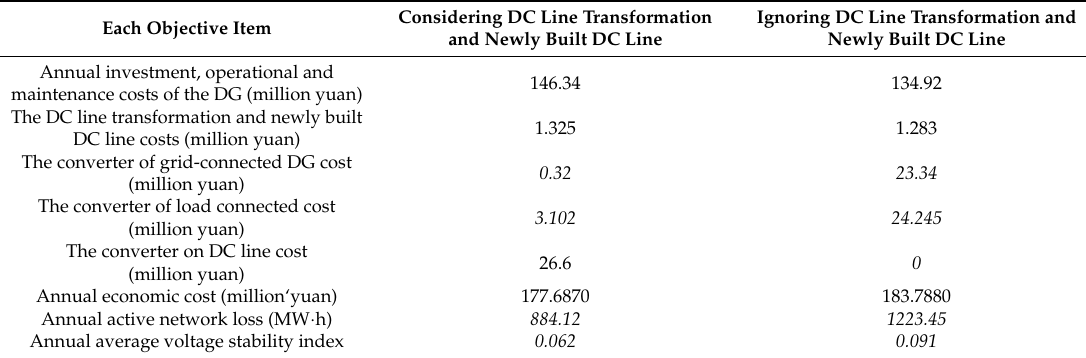
Table 6. The objective function values when considering the DC planning scheme.